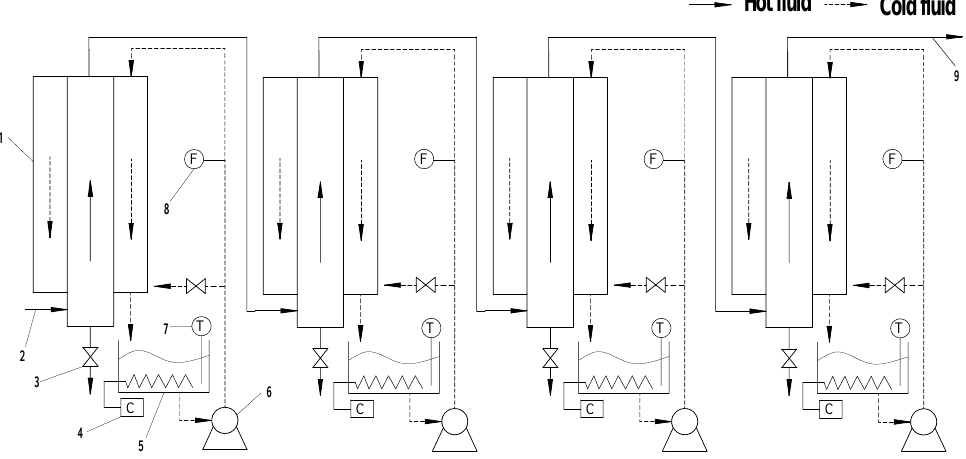
Figure 9. Schematic diagram of the four-stage condensers experimental apparatus for thermodynamic characteristics: (1) dual tube heat exchanger; (2) pyrolysis steam inlet; (3) ball valve; (4) heater; (5) water tank; (6) circulation pump; (7) thermometer; (8) rotor flow meter; (9) non-condensable gas outlet.